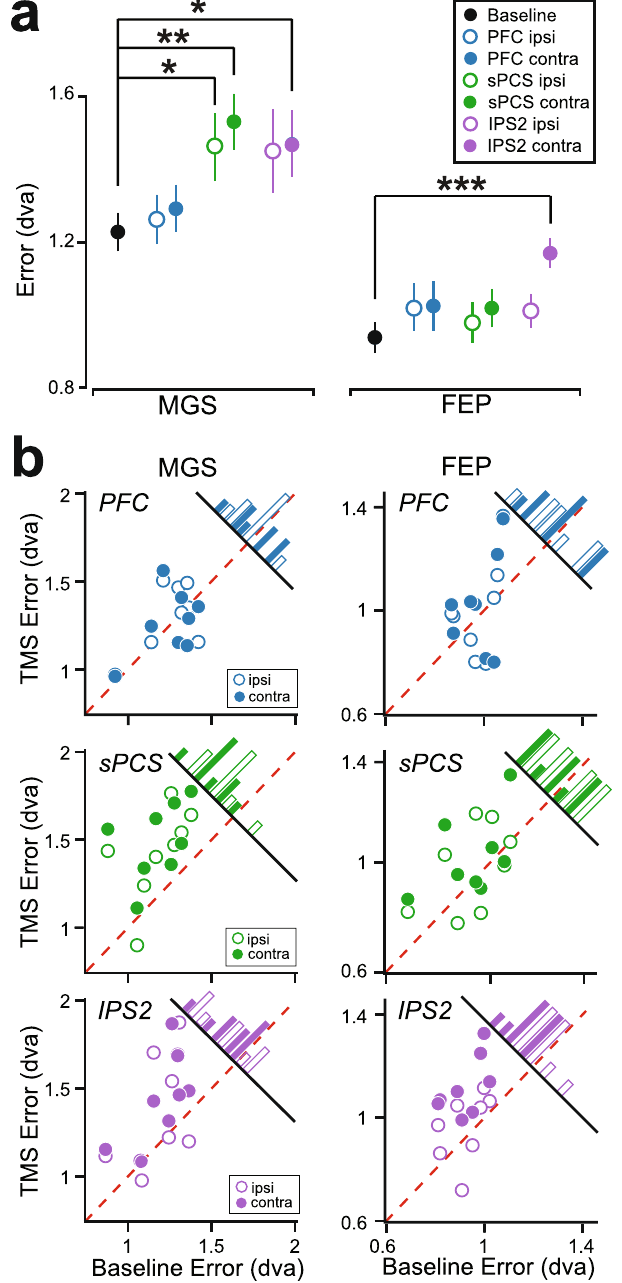
Figure 2. Group average and individual working memory performance. ( a ) Compared to a baseline no TMS condition, sPCS TMS caused an increase in mean MGS errors especially in the visual field contralateral to the hemisphere of TMS, but not FEP errors. IPS2 TMS impaired mean FEP errors in the contralateral visual field. Dorsolateral PFC TMS caused no observable impairments. † p < = 0.08, * p < = 0.05, ** p < = .005, *** p < = 0.0005. Error bars represent standard error of the mean. ( b ) Distribution of effects of TMS on working memory performance. TMS induced error (y-axis) is plotted against baseline error (x-axis) for both MGS and FEP, following PFC, sPCS, and IPS2 TMS. Histograms show the distributions of TMS induced error. Note that individual performance is remarkably consistent across subjects, and parallels the group-level results. For instance, sPCS TMS caused increased MGS error compared to baseline for every subject (all dots are to the left of the red dashed identity line). Additionally, IPS2 TMS caused increased FEP errors in every